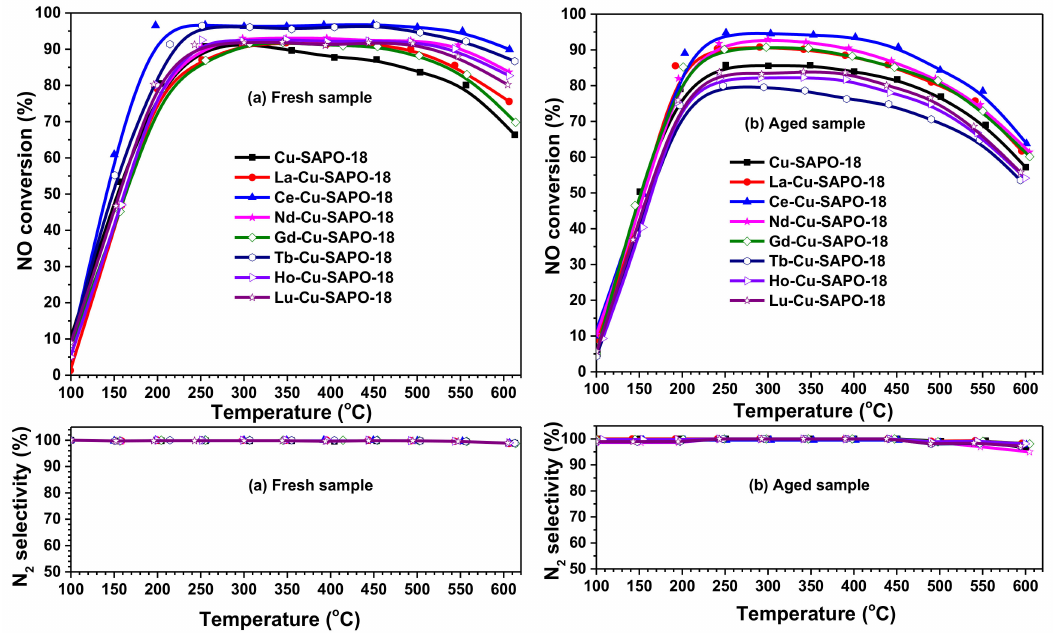
Figure 1. NO conversion and N 2 selectivity as a function of temperature for the selective catalytic reduction of NH 3 (NH 3 -SCR) reaction over the ( a ) fresh and ( b ) hydrothermally aged Cu-SAPO-18 and M-Cu-SAPO-18 samples at a gas hour space velocity (GHSV) of 130,000 h − 1 . The reactant feed composition: 500 ppm NO, 500 ppm NH 3 , 14 vol % O 2 , 5 vol % H 2 O, and N 2